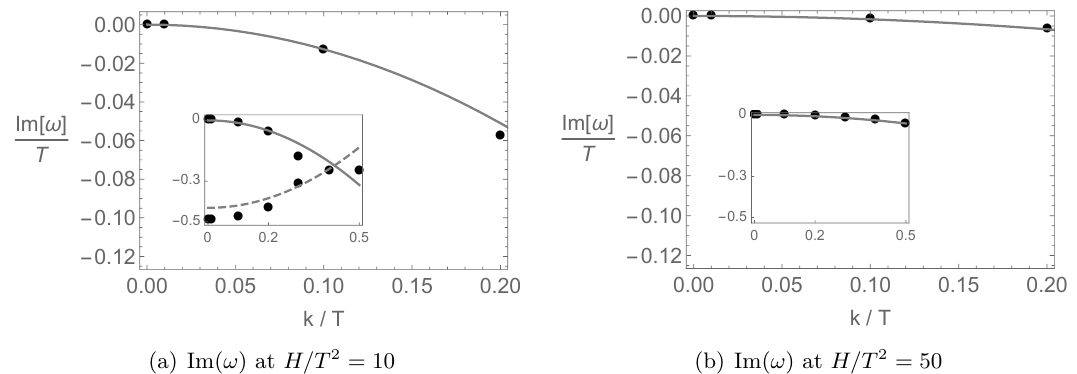
Figure 7 . Black dots are numerically computed quasi-normal modes and the gray solid line is (4.13), the gray dashed line is (4.14). These figures show that even in the large H case, the diffusive mode (gray solid line) could still be a good approximation to the quasi-normal modes, unlike the pseudo diffusive mode (gray dashed line). The insets display quasi-normal modes in a wider window. Note that a dashed line in the right figure is out of the